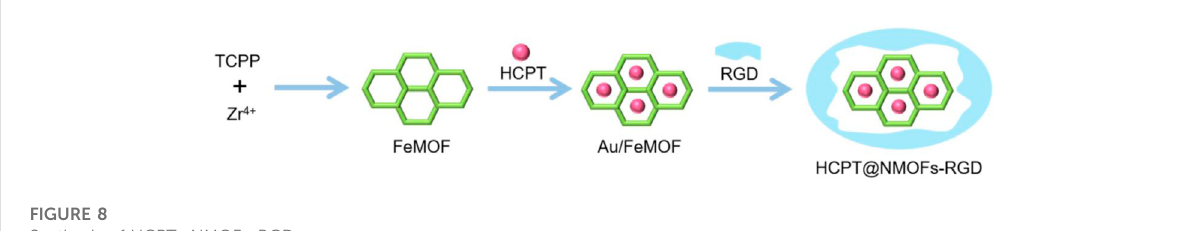
FIGURE 8 Synthesis of HCPT@NMOFs-RGD.